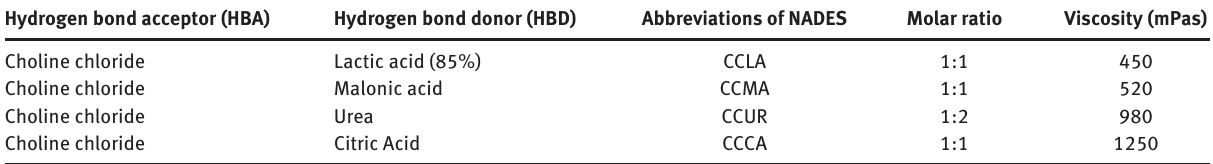
Table 1: Studied NADES with their abbreviations as well as the molar ratio between HBD and HBA and viscosity at 24°C. Hydrogen bond acceptor